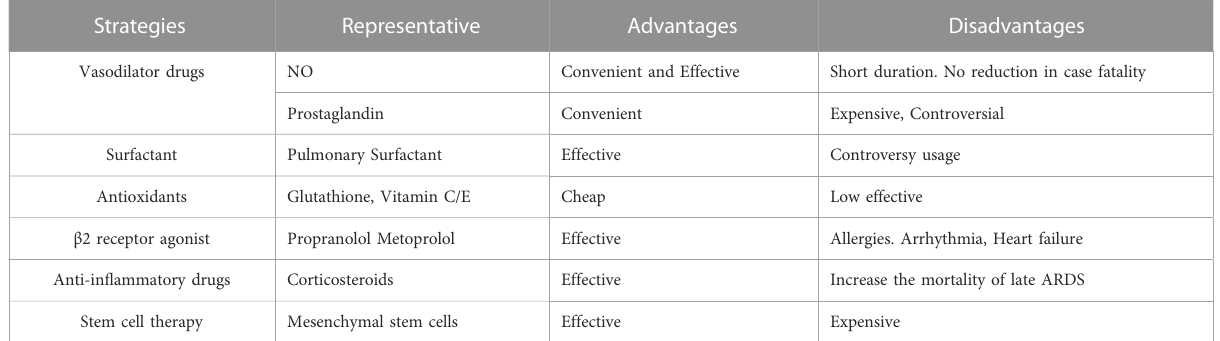
TABLE 1 Advantages and disadvantages of existing acute lung injury (ALI) treatment